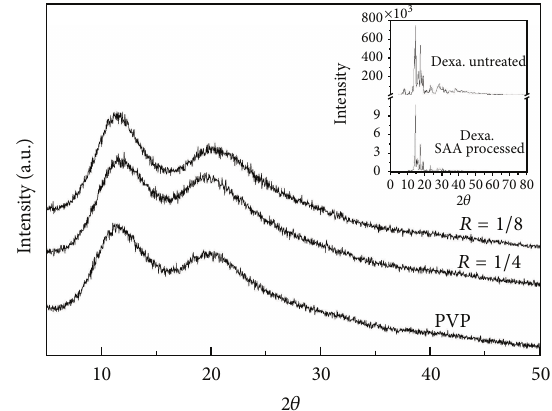
Figure 7: XRPD related to the PVP untreated and PVP microparti- cles produced by SAA using different